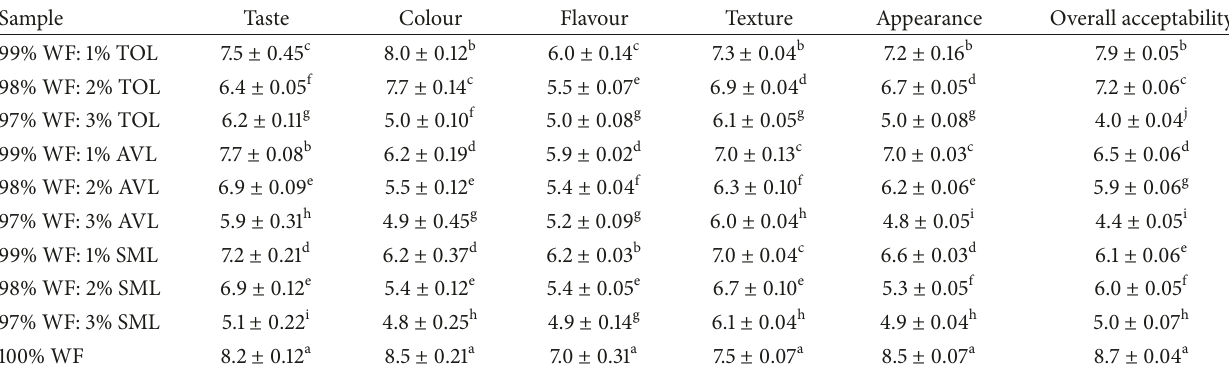
Table 6: Sensory properties of wheat bread fortified with green leafy vegetable powders.